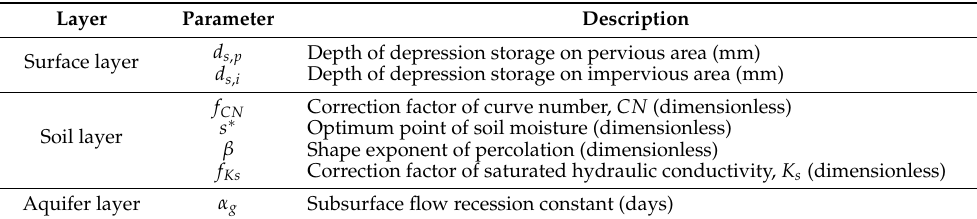
Table 1. Calibration parameters in hydrological model.